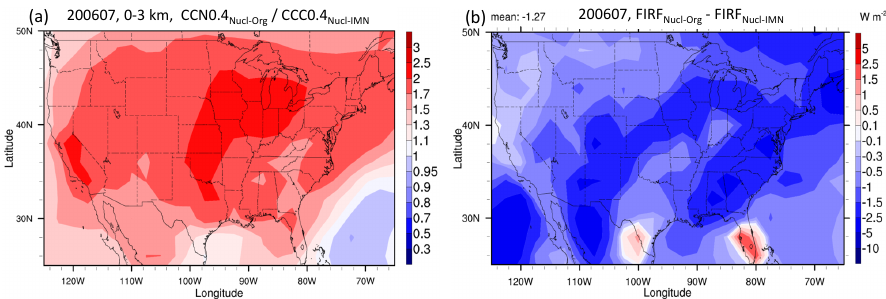
Figure 5. (a) Ratios of the concentration of CCN (at water supersaturation ratio of 0.4%) in the lower troposphere (0–3km) based on Nucl-Org scheme to those based on Nucl-IMN scheme, and (b) difference of aerosol first indirect radiative forcing (FIRF) (FIRF Nucl-Org – FIRF Nucl-IMN )